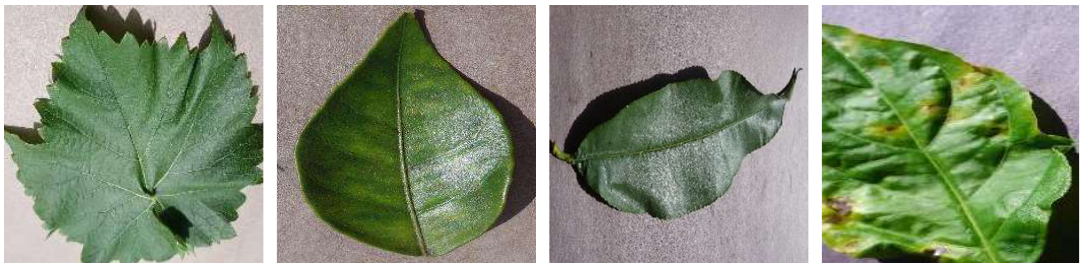
Figure 9. Sample augmented images using position augmentation techniques.